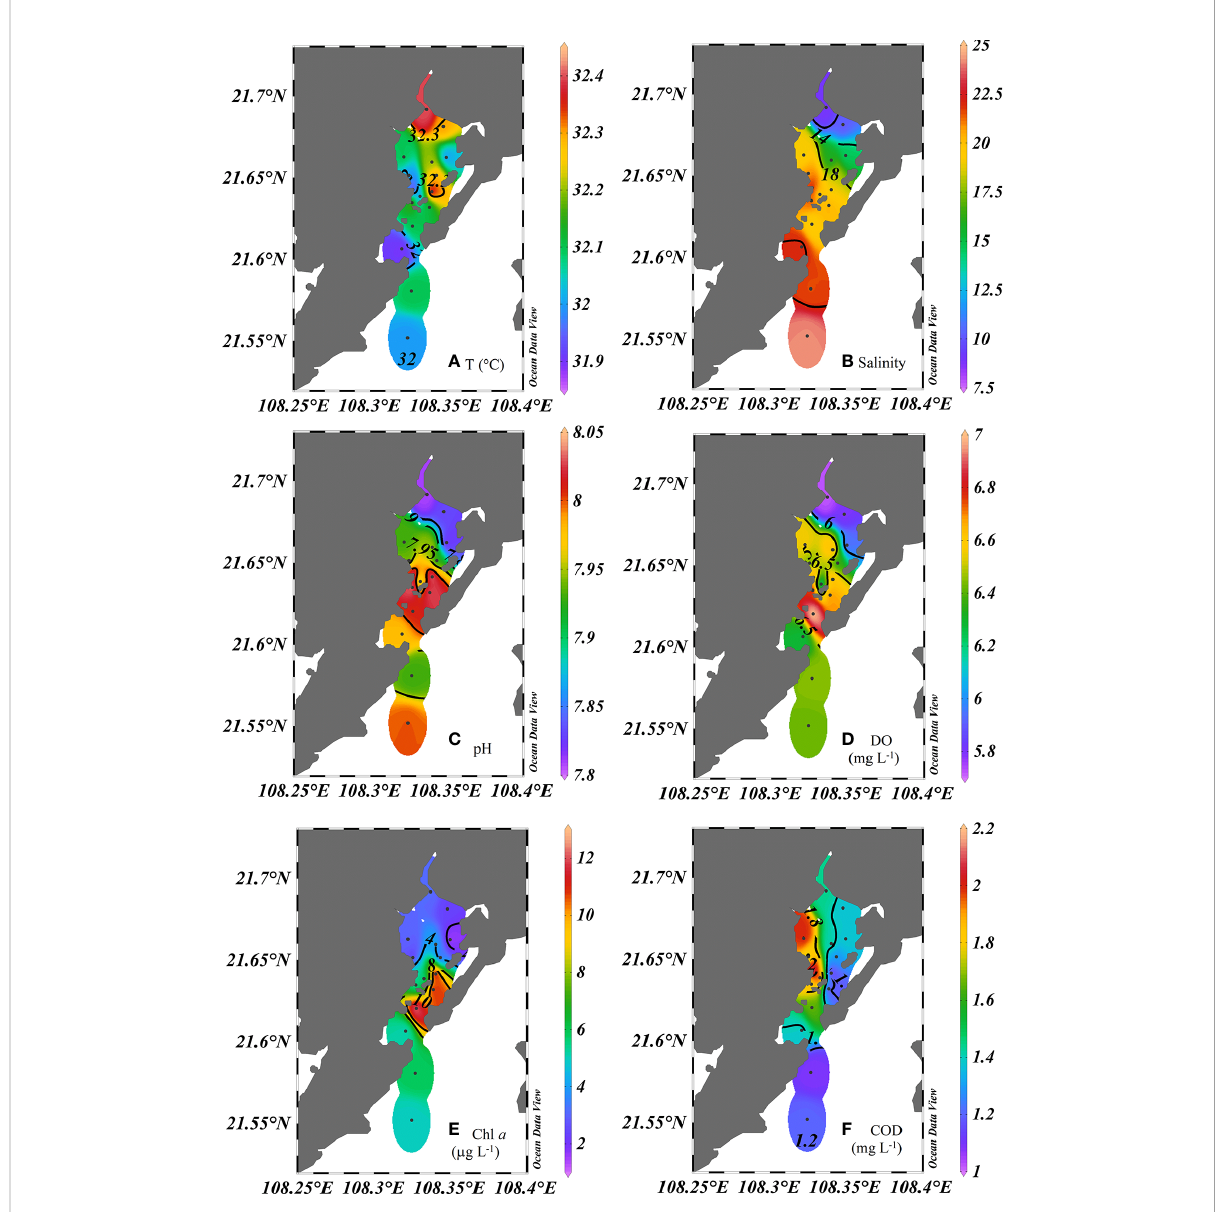
FIGURE 2 Spatial distributions of physicochemical parameters, including temperature (A) , salinity (B) , pH (C) , DO (D) , Chl a (E) and COD (F) , in Xi Bay during the rainy